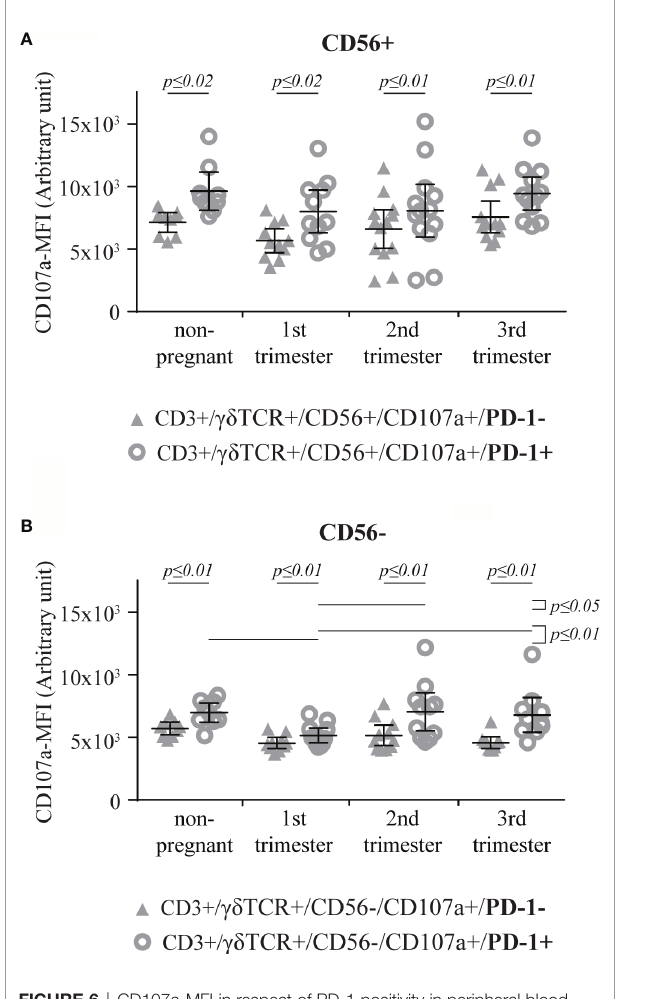
FIGURE 6 | CD107a-MFI in respect of PD-1 positivity in peripheral blood CD56+ (A) or CD56 − (B) gd T cells (CD3+/ gd TCR+) in non-pregnant (n = 9) and pregnant [1 st (n = 10), 2 nd (n = 10), and 3 rd (n = 13) trimester] women. The means are depicted as a horizontal line with the 95% con fi dence interval represented by whiskers. The individual data points are shown as triangles (CD3+/ gd TCR+/CD56+/CD107a+/PD-1 − or CD3+/ gd TCR+/CD56 − /CD107a +/PD-1 − , respectively) or circles (CD3+/ gd TCR+/CD56+/CD107a+/PD-1+ or CD3+/ gd TCR+/CD56 − /CD107a+/PD-1+, respectively). Statistical analysis was performed by using the paired-samples-t-test to compare data between the PD-1+ and PD-1 − gd T cell population and the unpaired-samples-t-test to compare within the same population but at different timepoints. Signi fi cant differences are depicted by a horizontal line above the respective data